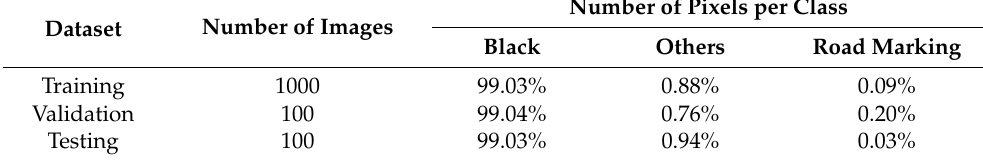
Table 1. Dataset